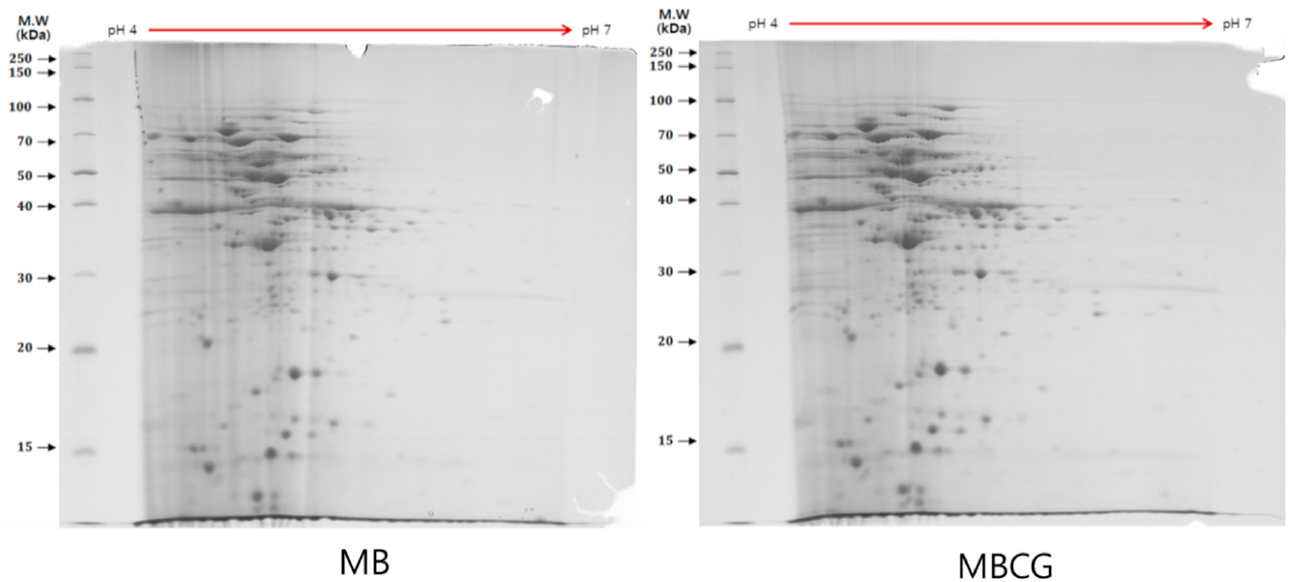
Figure 1. WK protein expression patterns of the MB or MBCG medium. Table 2. WK proteins identified in different growth conditions (MB and MBCG). Spot No.